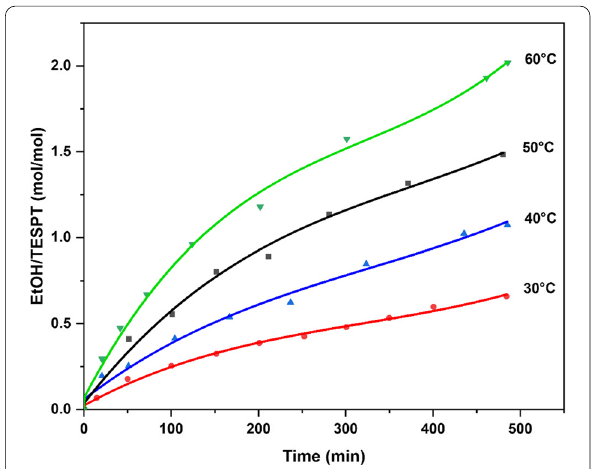
Fig. 9 Temperature dependency of primary silanization reaction concerning silanization time [51]